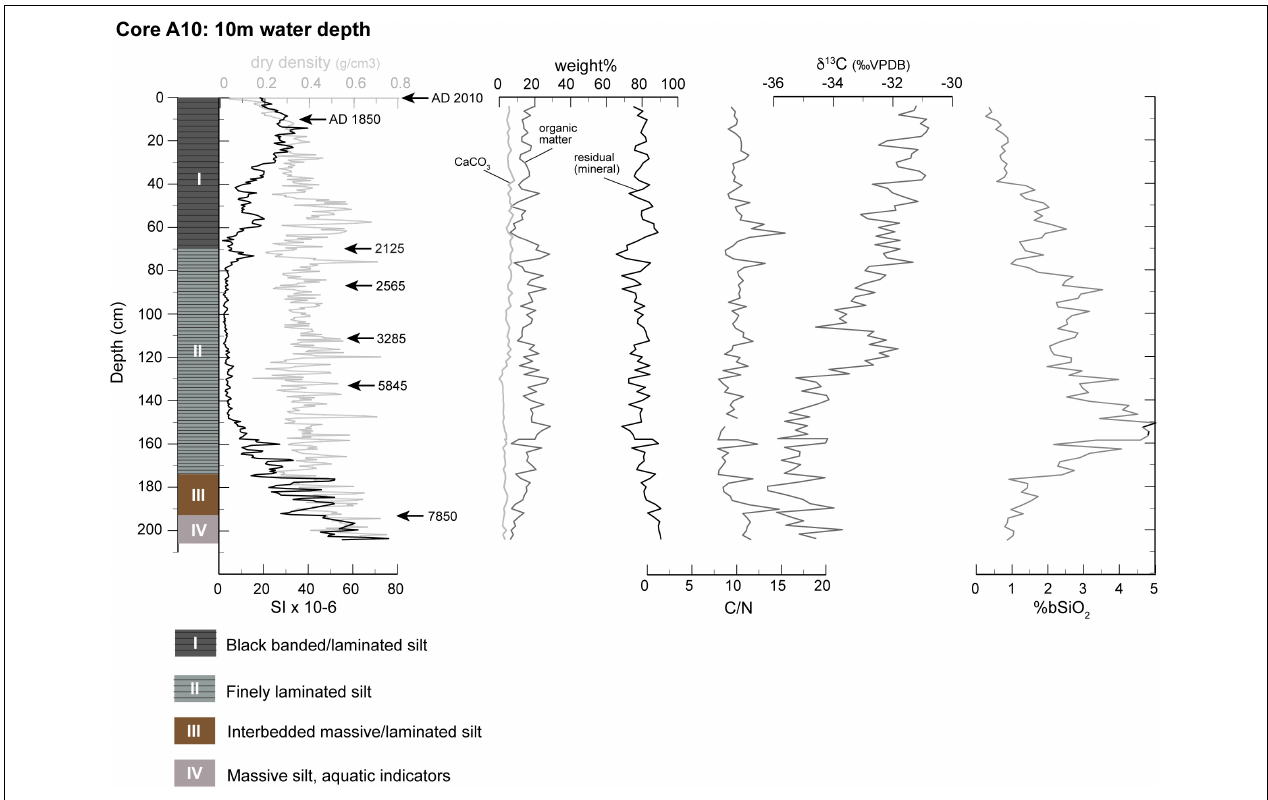
FIGURE 4 | Sediment core A lithology, physical and geochemical properties, and radiocarbon ages in cal yr BP (arrows): magnetic susceptibility (SI × 10 - 6 ), dry bulk density (g/cm 3 ), weight percentages (weight%) calcium carbonate (CaCO 3 ), organic matter, and residual mineral matter, organic C/N ratio, organic matter δ 13 C values ( VPDB), and weight percentages of biogenic silica (%bSiO 2 (cid:104)